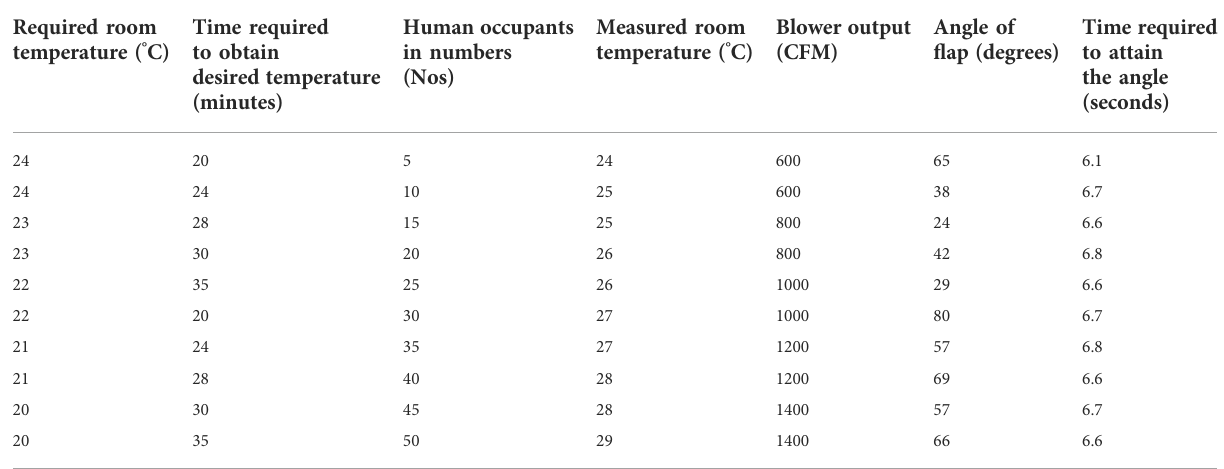
TABLE 1 Performance of controller when parameters